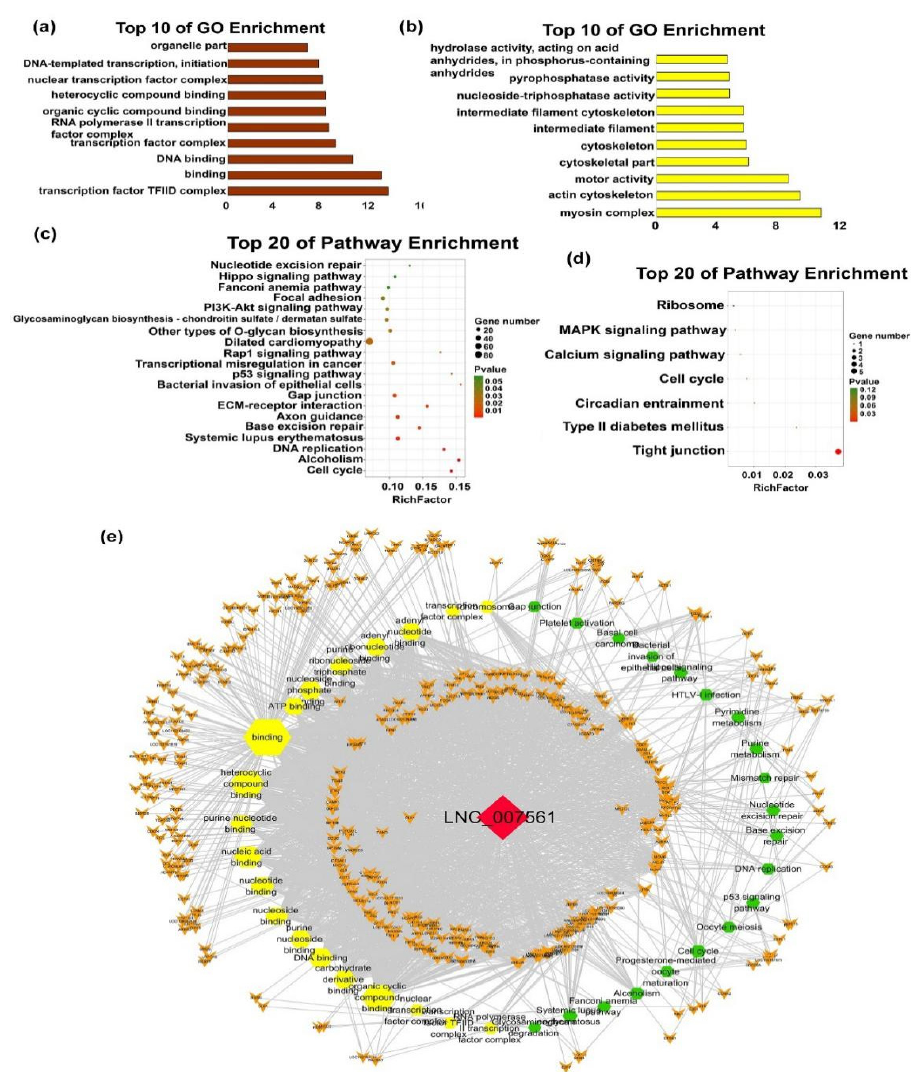
Figure 6. Functional and pathway enrichment of late modules. ( a , b ) Bar plots showing the top 10 enriched GO terms in M3 (Brown) and M5 (Yellow). The length of the bars indicates significance ( − log 10 P -value). ( c , d ) Top 20 enriched gene pathway terms of the all M3 ( c ) and M5 ( d ) lncRNAs. ( e ) Function network of the LNC_007561. The green hexagonal denotes the pathway analysis, yellow hexagonal denotes enrichen GO terms, the red diamond represents lncRNA, the orange V shape represents mRNAs, and the size is expressed in degrees.